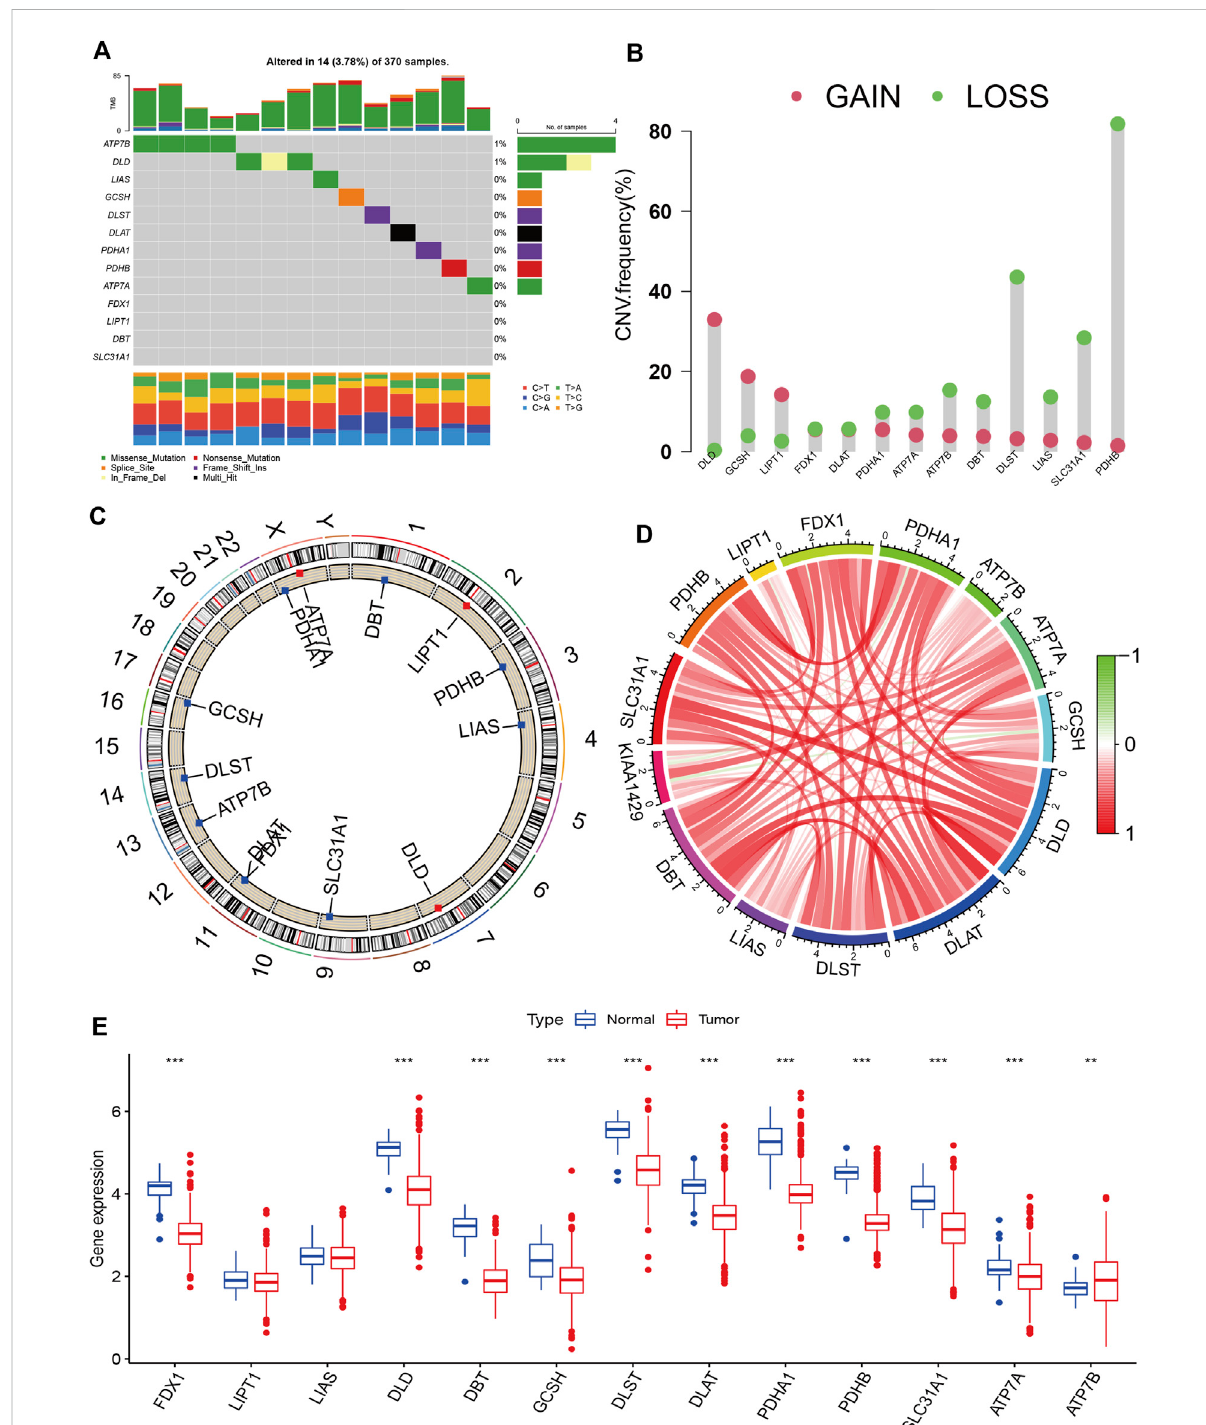
Landscape of cuproptosis regulators in KIRC. (A) : Gene alterations of cuproptosis regulators. (B) : Copy number variation frequency of cuproptosis regulators. (C) : Chromosome ideograms and labelled chromosomes. (D) : Correlation circle among cuproptosis regulators. (E) : Differentially gene expression analysis of cuproptosis regulators between normal and tumor